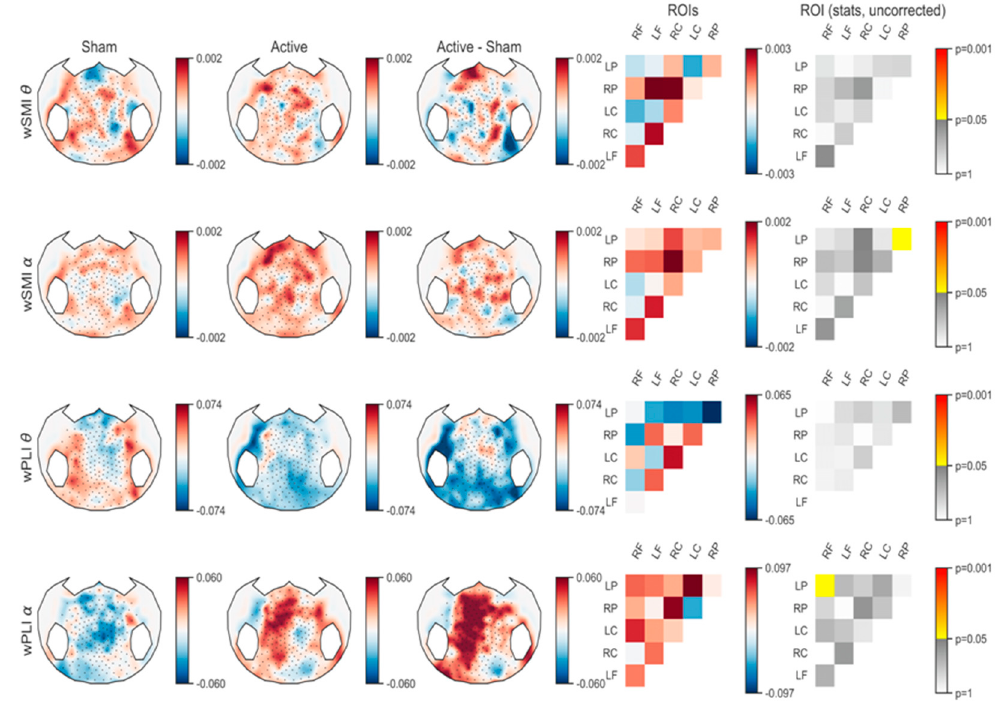
Figure 4. Connectivity differences in sham and active tDCS and active compared to sham sessions.